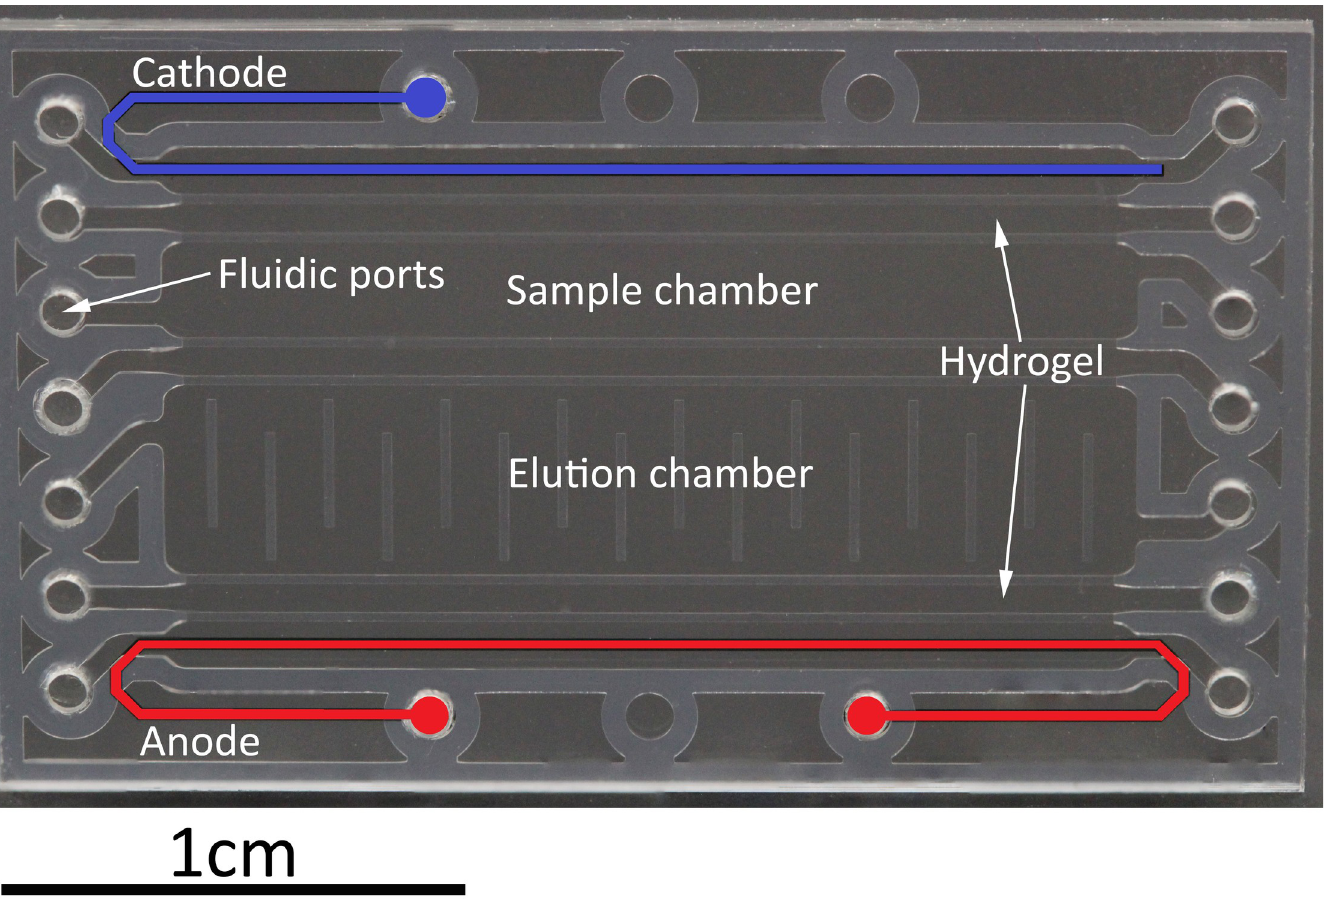
Fig 1. Chip system used for miRNA extraction. The sample chamber (5 μ l) and elution chamber (10 μ l) are separated by a hydrogel. The cathode (blue) and anode (red) are inside fluidic channels that are electrically connected to the sample and elution chambers by hydrogels. Controlled filling and emptying of the elution chamber is facilitated by capillary pressure